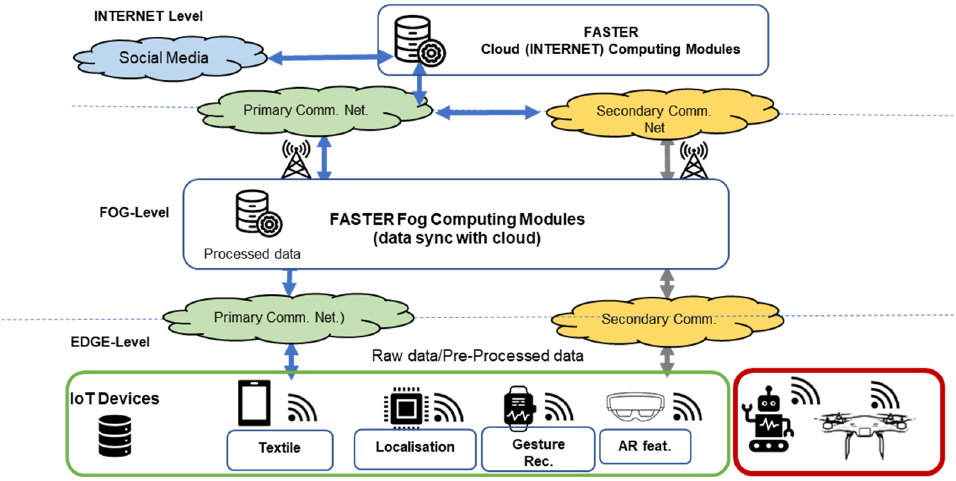
Figure 1. FASTER logical